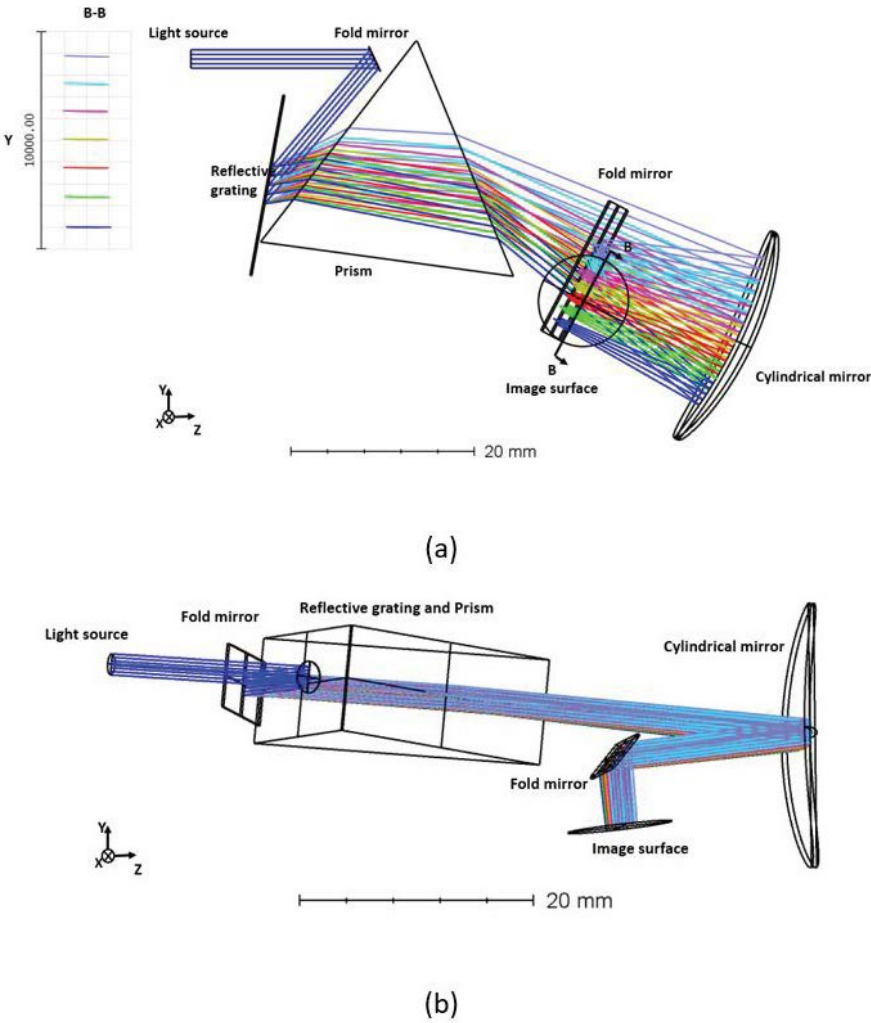
Figure 4. Design of a spectrometer with a prism and reflective grating ( a ) side view; ( b ) top view.